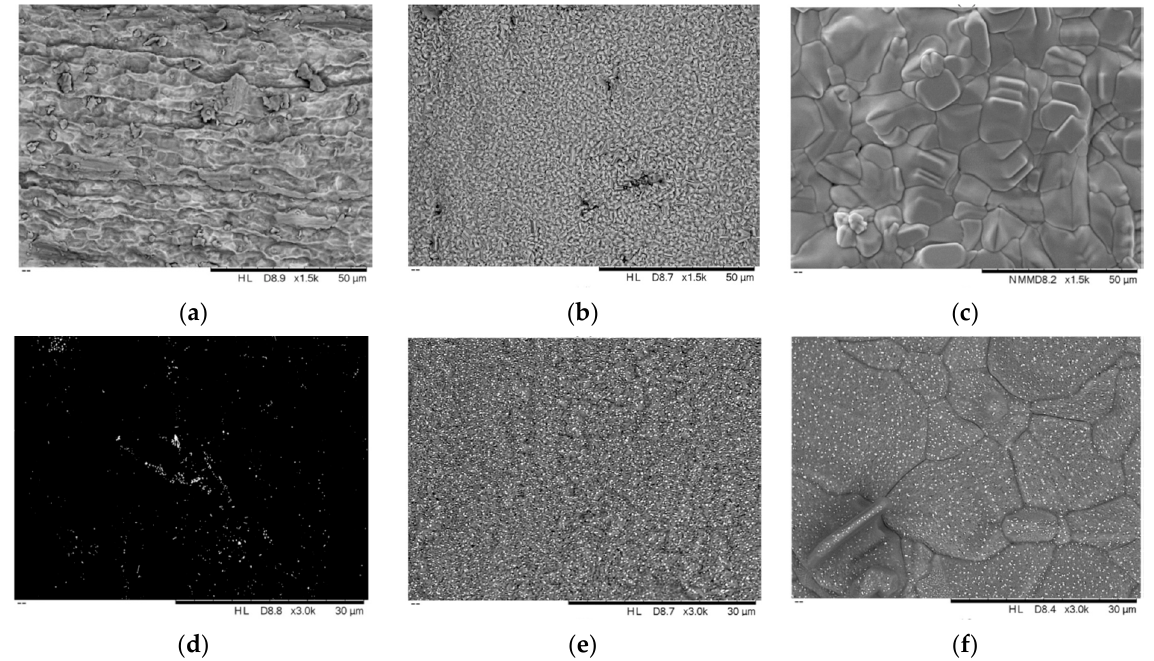
Figure 11. SEM micrographs of the Ti mesh support calcined at 600 °C ( a ), 900 °C ( b ), and 1200 °C ( c ); backscattered scanning electron (BSE) micrographs of the Pt catalyst after 5 h hydrogen combustion prepared using a Ti mesh calcined at 600 °C ( d ), 900 °C ( e ), and 1200 °C ( f ) (reproduced from [128] with permission from Elsevier).